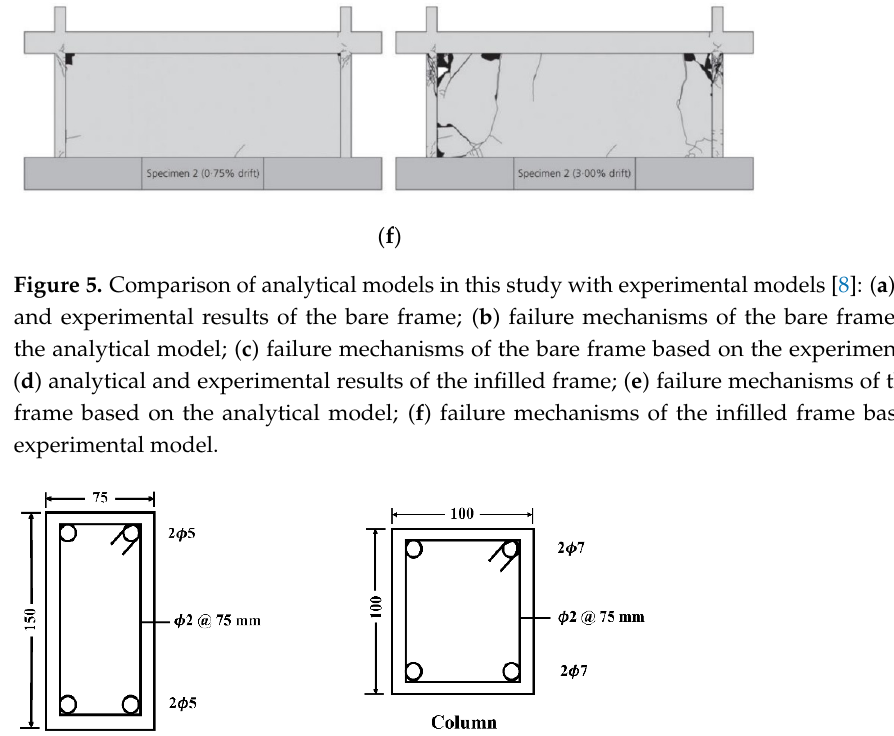
Figure 6. Cross-sections of the beam and column of Van and Lau [41]. Table 3. Material properties of Van and Lau [41].